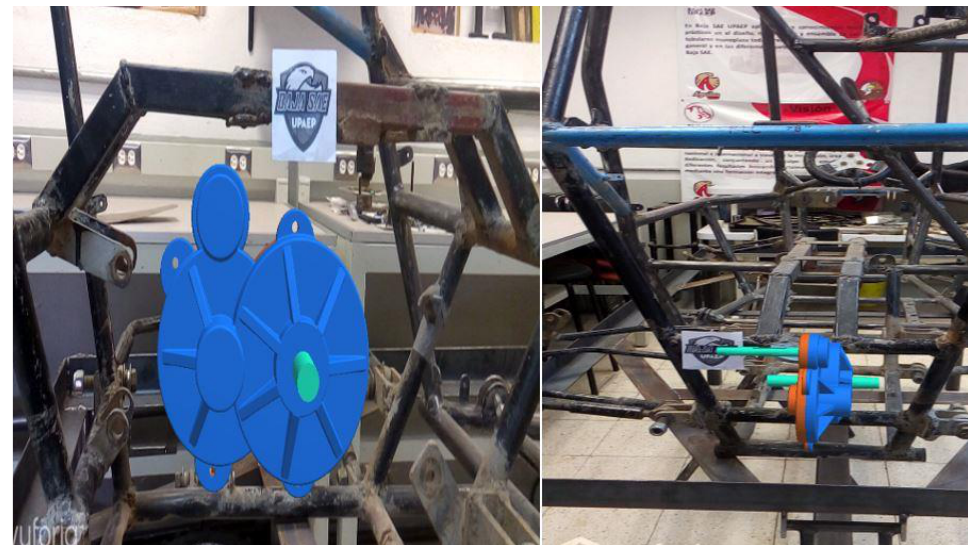
Figure 6. Transmission validation for the Baja SAE-UPAEP project at the VR/AR laboratory at UPAEP (2019–2020).